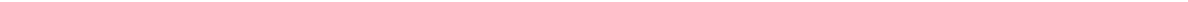
Fig. 3 TACI uses a MyD88-binding site to attach the central domain of mTOR. a Left graphs: structure of His-tagged WT TACI or D1 and D2 TACI deletion mutants. Numbers indicate C-terminal and N-terminal residues. ED extracellular domain, TD transmembrane domain, CD cytoplasmic domain. Right gels: IB of mTOR, MyD88 and TACI following IP with anti-His or irrelevant IgG antibodies of protein lysates from transfected 293 cells expressing WT, D1, or D2 TACI. Red numbers indicate band intensity relative to TACI. b NF- κ B luciferase (NF- κ B-Luc) reporter assay of 293 cells transfected with WT or mutant TACI shown as in a . Ctrl, 293 cells transfected with an empty plasmid. c IB of mTOR, MyD88, and TACI following IP with anti-His or irrelevant IgG antibodies of protein lysates from transfected 293 cells expressing His-tagged WT TACI or mutant TACI proteins with site-targeted substitutions inhibiting MyD88 binding to the cytoplasmic MBS of TACI, including S231R TACI and C233G TACI. d Left graphs: structure of FLAG-tagged WT MyD88 or D1, D2, D3, and D4 MyD88 deletion mutants. Right gels: IB of MYC and FLAG following IP with anti-FLAG or irrelevant IgG antibodies of protein lysates from co-transfected 293 cells expressing FLAG-tagged WT, D1, D2, D3, and D4 MyD88 together with MYC-tagged mTOR. Red arrows indicate nonspeci fi c bands. e NF- κ B-Luc reporter assay of 293 cells co-transfected with WT TACI and WT or mutant MyD88 shown in d for 24 h. Ctrl, 293 cells transfected with an empty plasmid. f Left graphs: structure of MYC-tagged WT mTOR or D1, D2, and D3 mTOR deletion mutants. FAT stands for FRAP, ATM, TRRAP domain. Right gels: IB of MYC and HA following IP with anti-HA or irrelevant IgG antibodies of protein lysates from co-transfected 293 cells expressing MYC-tagged WT, D1, D2, and D3 mTOR together with HA-tagged MyD88. Data represent one of three experiments with similar results ( a , c , d , f )